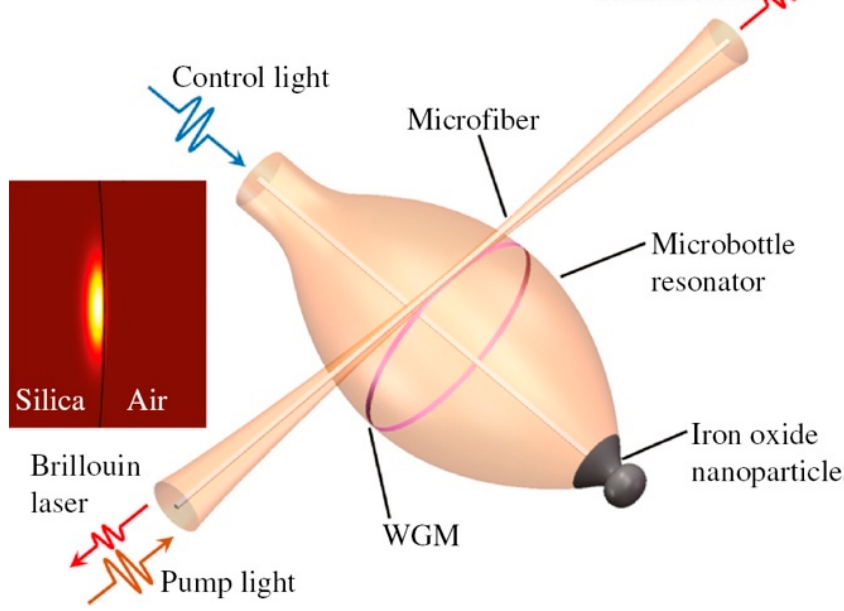
Figure 11. Sketch of the tunable Brillouin laser and Raman laser implemented in a hybrid microbottle resonator. The inset shows the fundamental mode field distribution of the resonator with a diameter of 114 µ m. Reproduced from [86] under a Creative Commons license.